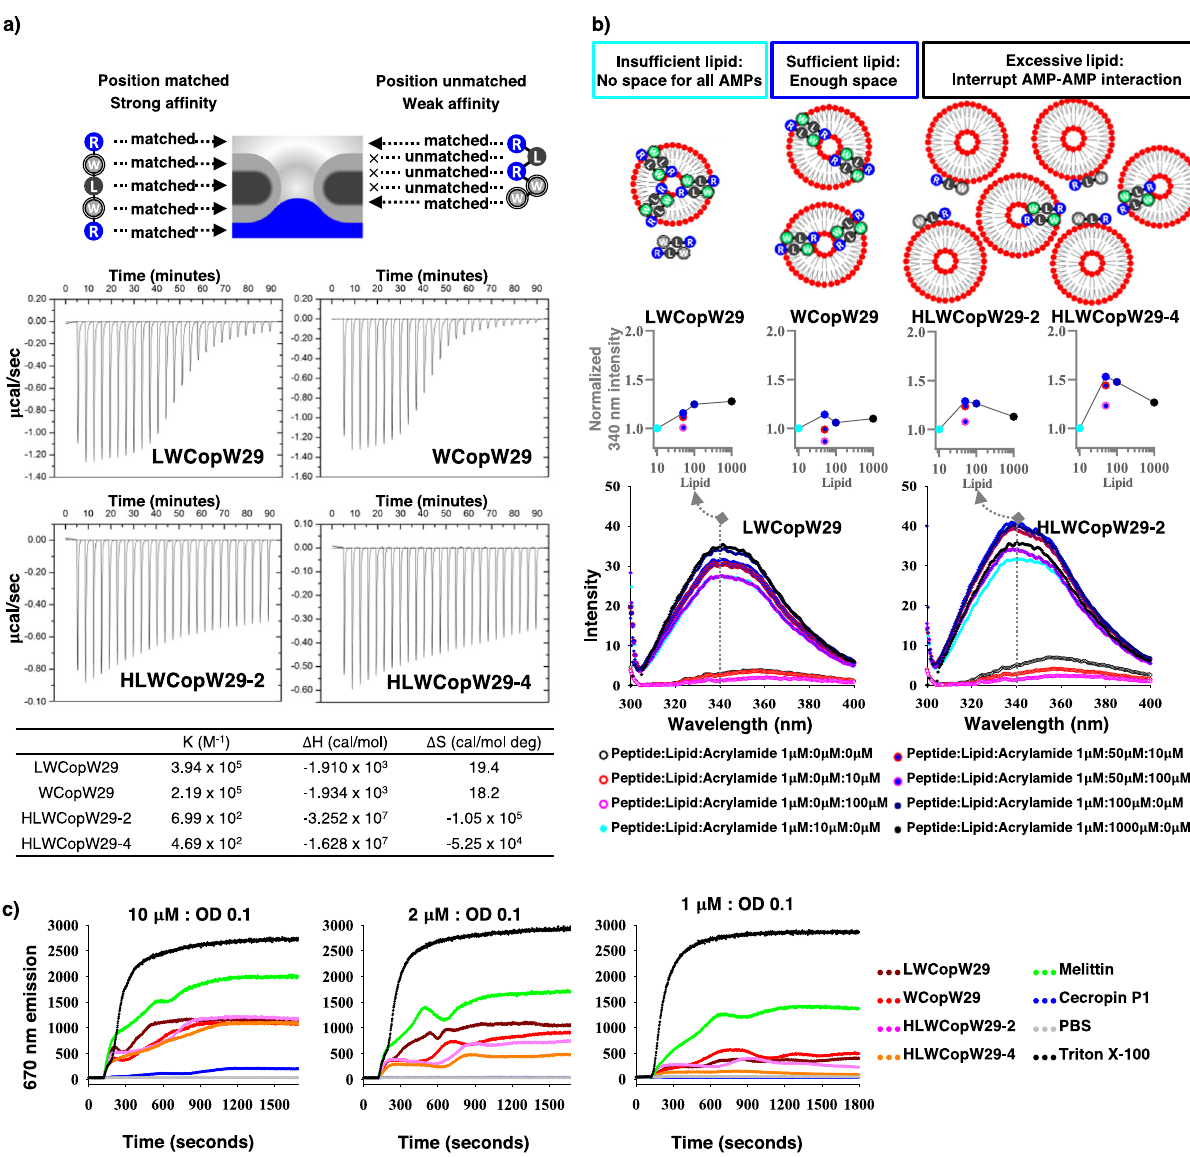
Fig. 2 Comparisons of peptide-lipid interactions. a Isothermal titration calorimetry measurements of peptide interactions with DMPC:DMPG liposomes. Δ H indicates the enthalpy change. Δ S indicates the entropy change. The binding constant (or the association constant K, M – 1) is the inverse of the dissociation constant (Kd). The larger binding constants of LWCopW29 and WCopW29 indicate these peptides have high af fi nity for the arti fi cial bacterial membrane liposomes. An independent experiment yielded the same results (Supplementary Fig. 5). b Addition of DMPC:DMPG liposomes changed the tryptophan fl uorescence intensity of the peptides. In the graphs, the 340 nm maxima intensity values were normalized to the initial fl uorescence value to allow comparisons of fl uorescence intensities. A quencher (water or acrylamide) decreased the fl uorescence intensity, while environmental hydrophobicity (lipid) increased the fl uorescence intensity. Lipid concentrations are as follows: light blue, 10 μ M; blue, 50 μ M; dark blue, 100 μ M; black, 1000 μ M. The red dotted line indicates 10 μ M acrylamide; the pink dotted line, 100 μ M acrylamide. A high lipid concentration (1000 μ M) quenched HLWCopW29-2 and HLWCopW29-4 fl uorescence. This effect was comparable to that of acrylamide, indicting larger exposure of tryptophan to water. Independent experiments yielded the same results (Supplementary Fig. 6). c Proton-leakage increases DiSC3(5) fl uorescence in S. aureus . Peptides were added at 120 s. The fl uorescence intensities of the four analogs were similar at the HLWCopW29-2 and HLWCopW29-4 MIC against OD 0.1 S. aureus (10 μ M peptide each). The fl uorescence intensities of LWCopW29 and WCopW29 were higher at the LWCopW29 and WCopW29 MICs (2 μ M and 1 μ M, respectively) (Supplementary Table 2). An independent experiment yielded the same results (Supplementary Fig.